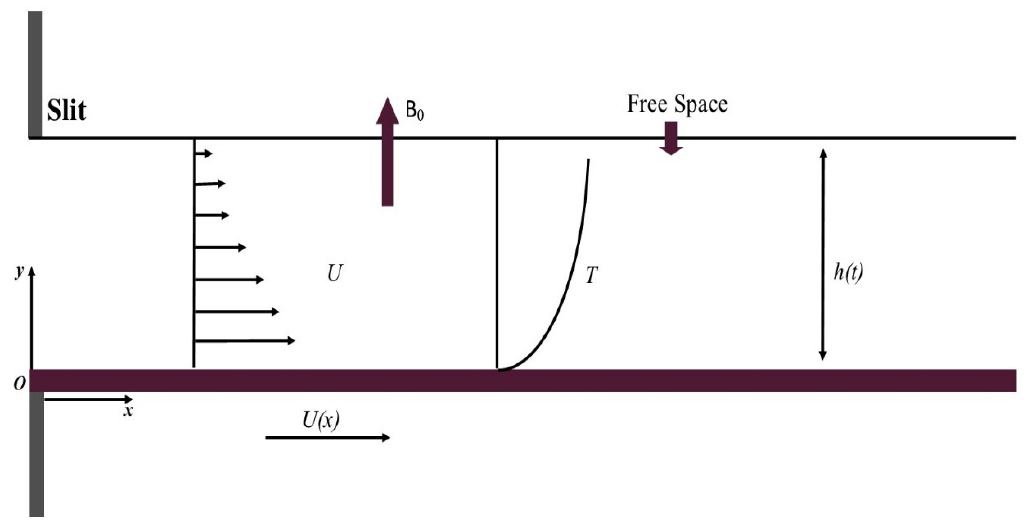
Figure 1. Geometry of the problem.